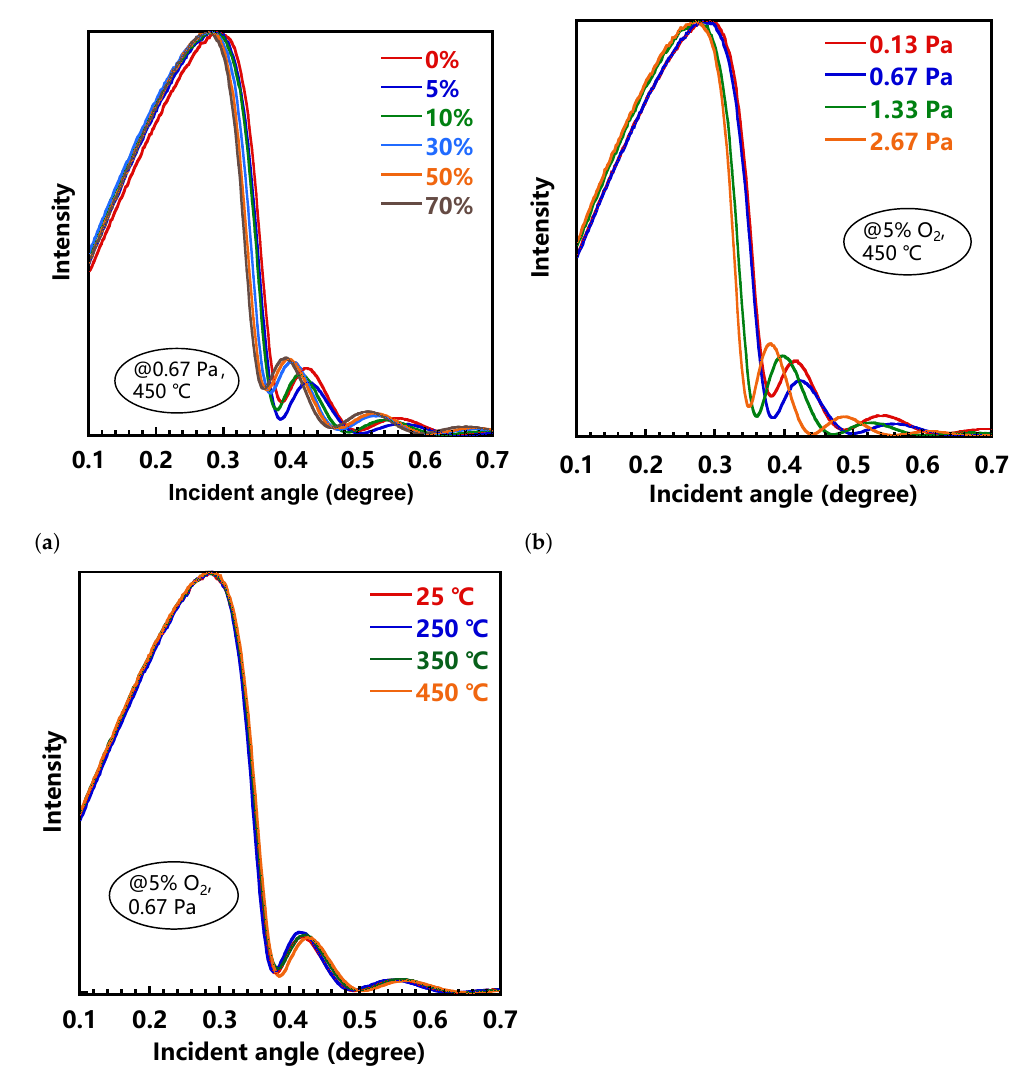
Figure 2. X-ray Reflectivity (XRR) curves collected from a-IGZO films prepared at ( a ) different O 2 /(Ar+O 2 ) ratio (for 0.67 Pa, 450 °C), ( b ) sputtering pressure (for 5% O 2 , 450 °C), and ( c ) annealing temperature (for 5%O 2 , 0.67